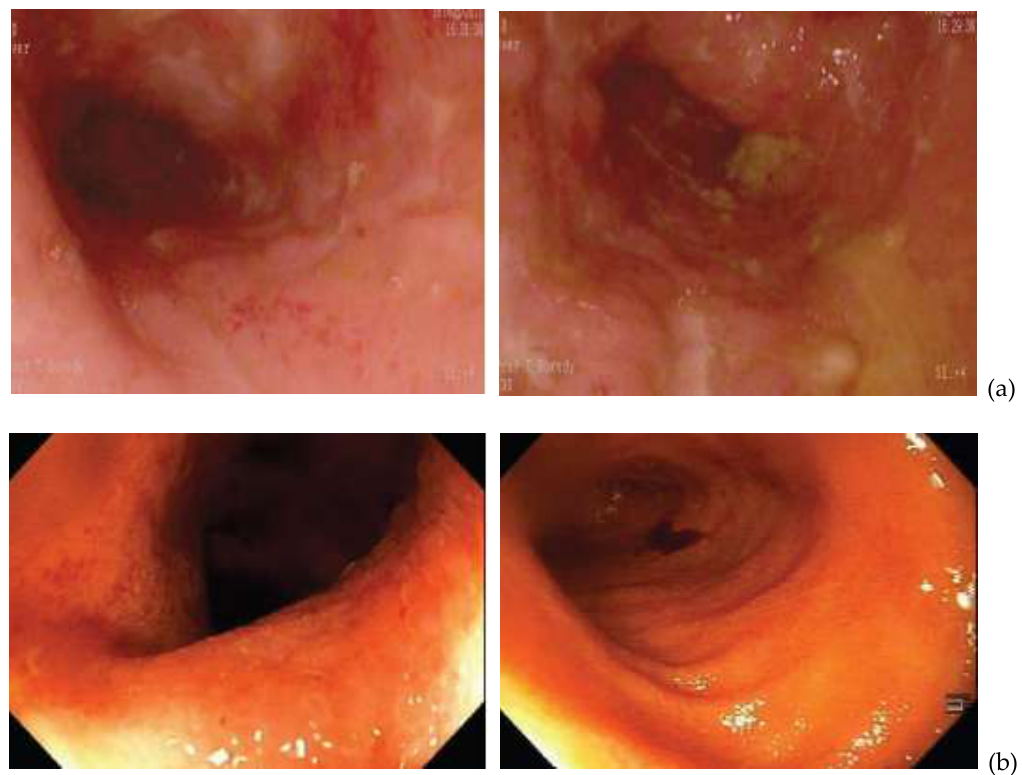
Figure 1. Improvement in terminal ileum inflammation following anti-mycobacterial antibiotic therapy (AMAT). ( a ) Patient 1: Initial view of inflamed, ulcerated terminal ileum (2011). ( b ) Patient 1: Follow-up view of the terminal ileum (2012). Healed mucosa showing healthy villi with some red clofazimine staining spots in the distal ileum.